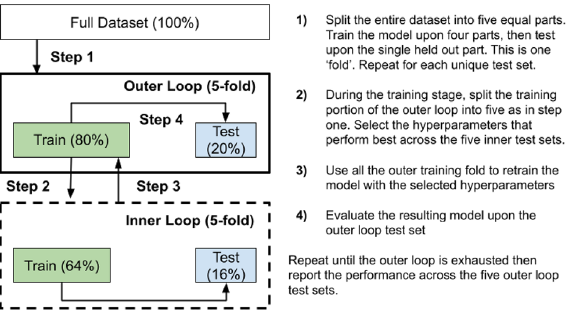
Figure 2. Evaluation strategy for machine learning models. Using a nested cross-validation strategy ensures that the model is always tested upon ’out of sample’ data it has never seen before. In the outer loop we assess the model’s performance. In the inner loop we try to find hyperparameters (settings for the model) that perform well within the training data.